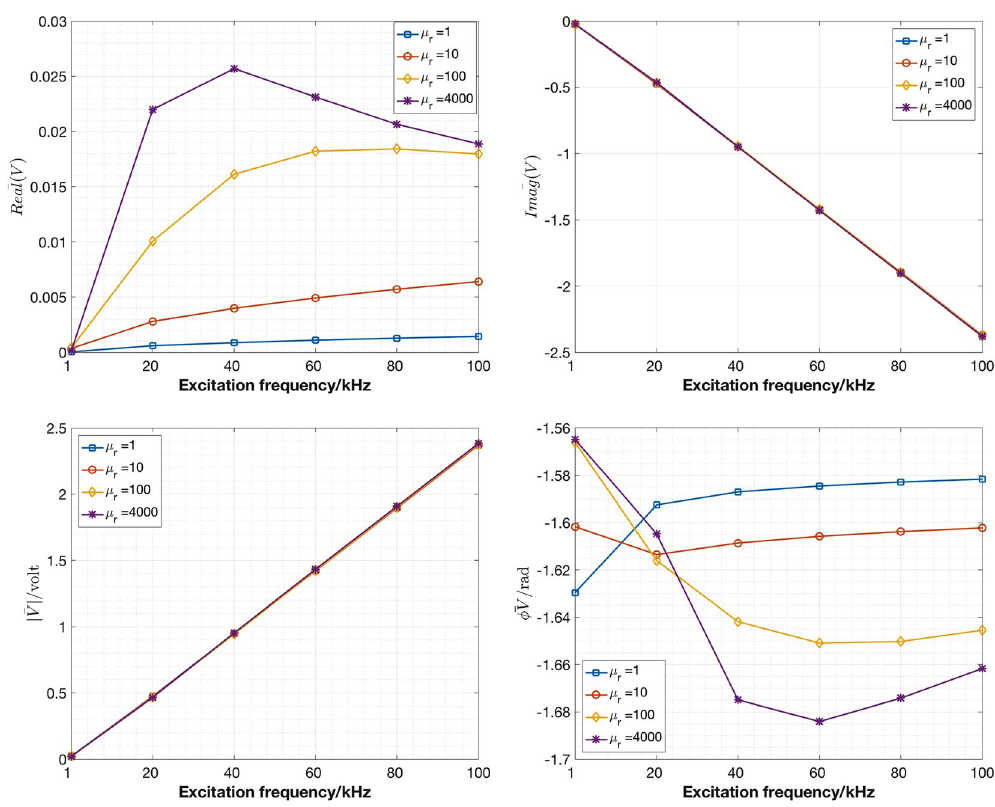
image reconstruction. The system has a frame rate of 0.2 frame/s, where one frame includes driving the excitation coils one at a time and measuring the receiving coils in sequence, transferring the measurements to a host PC, reconstructing and displaying an image using measurement data. Given that the frequency sweep interval is, at minimum, 5 s, it is safe to assume that any material response due to frequency differences is settled before the next interrogation within the ferromagnetic specimen under investigation.